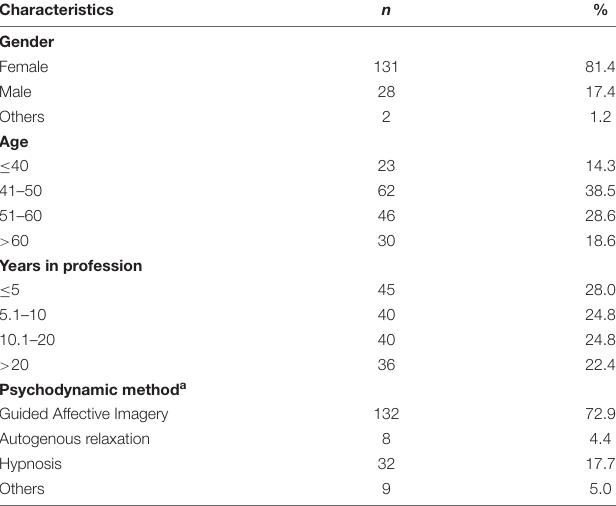
TABLE 1 | Sociodemographic characteristics of the